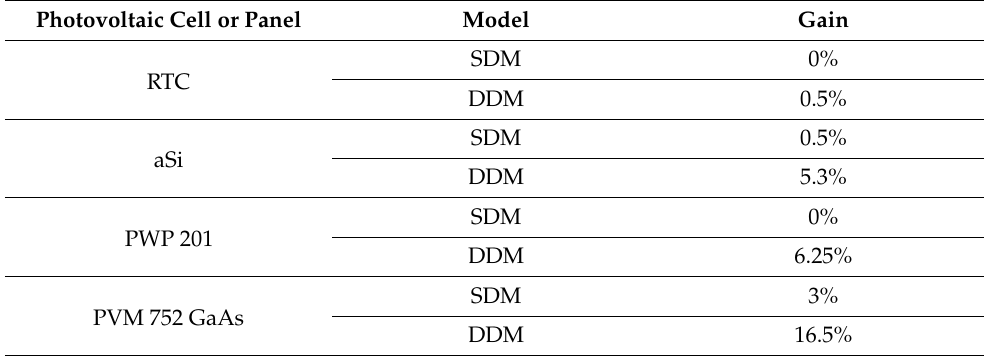
Table 10. The improvements in